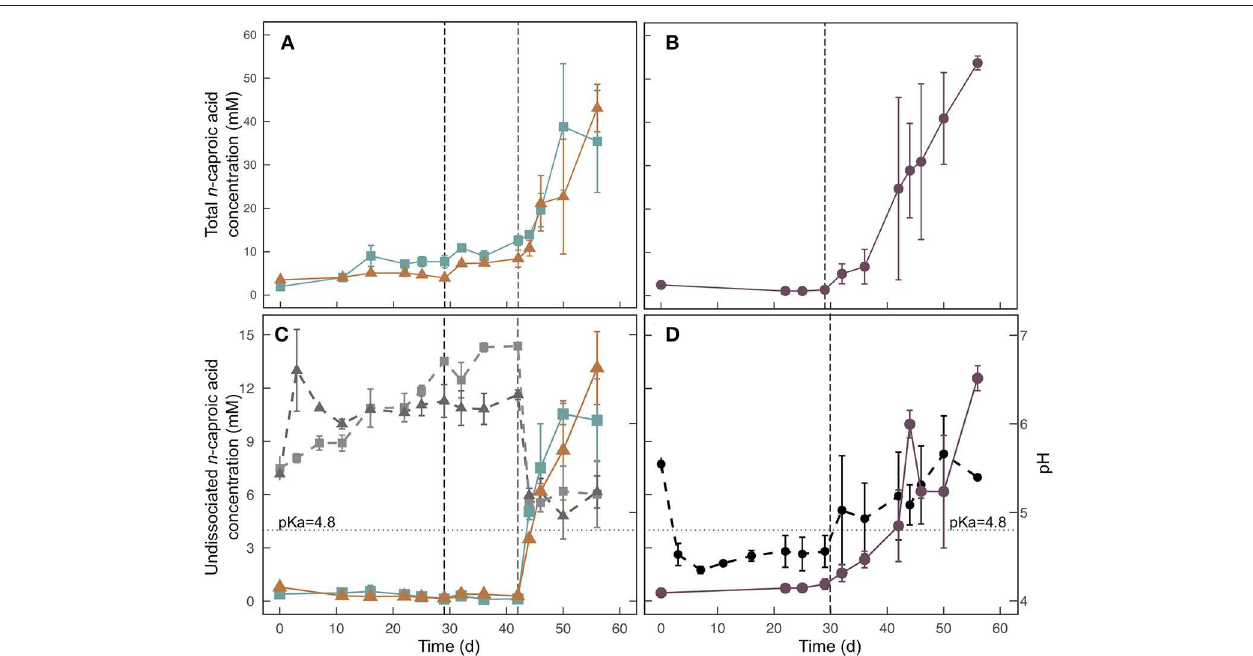
FIGURE 4 | Total n -caproic acid concentrations (A,B) , undissociated n -caproic acid concentrations, (C,D) and pH (C,D) for the field-scale trial during Experiment 3. For (C) and (D) , undissociated n -caproic acid concentrations (solid colored lines) are plotted against the left axis, and pH (dashed, ray-scale lines) is plotted against the right axis. Treatments ( (cid:4) ) and 2 ( N ), which were conducted in two stages are shown on the left (A,C) . Treatment 3 ( • ), which had banana waste mixed with UDDT-SW at initial startup is shown on the right (B,D) . Error bars show the range between duplicate barrels. The dashed vertical line at Day 29 indicates the time that barrels were moved into the greenhouse, and the average temperature increased from 22.1 to 26.9 ◦ C. The dashed vertical line at Day 42 in (A) and (C) indicates the time that banana waste was added to Treatments 1 and 2. The dotted horizontal line at pH = 4.8 indicates the pKa of carboxylic acids.